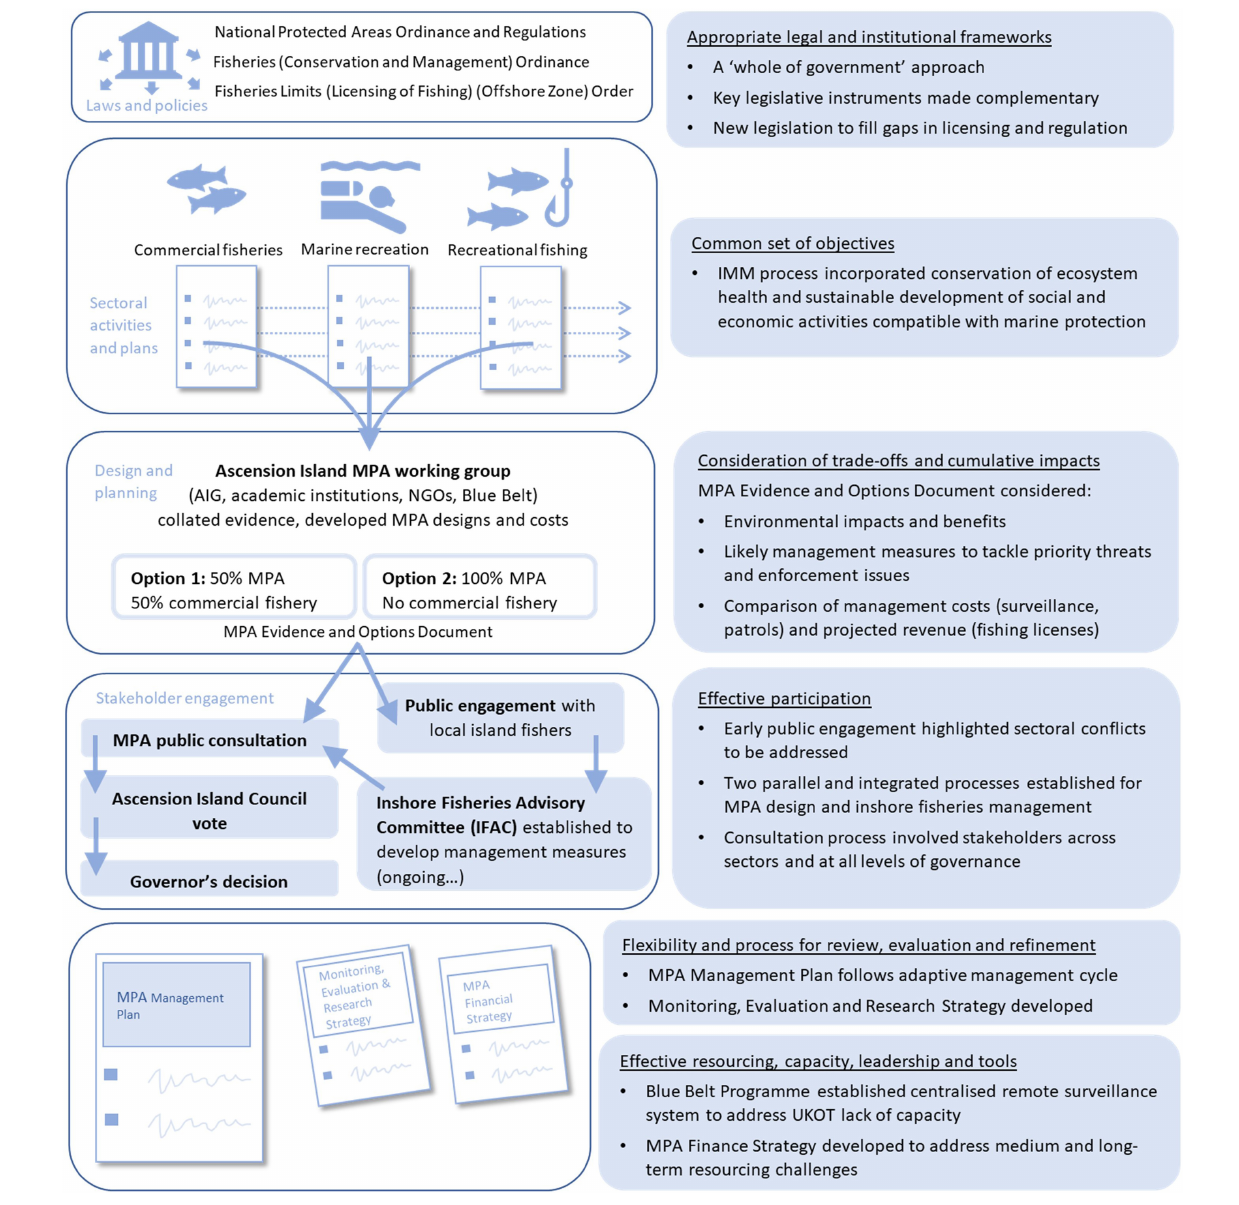
FIGURE 4 | Application of the Integrated Marine Management framework in Ascension